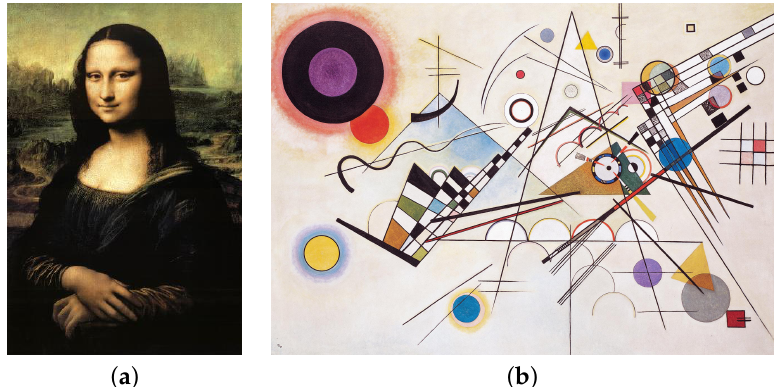
Figure 3. Samples from the WikiArt dataset. ( a ) Mona Lisa; ( b ) Composition VIII.